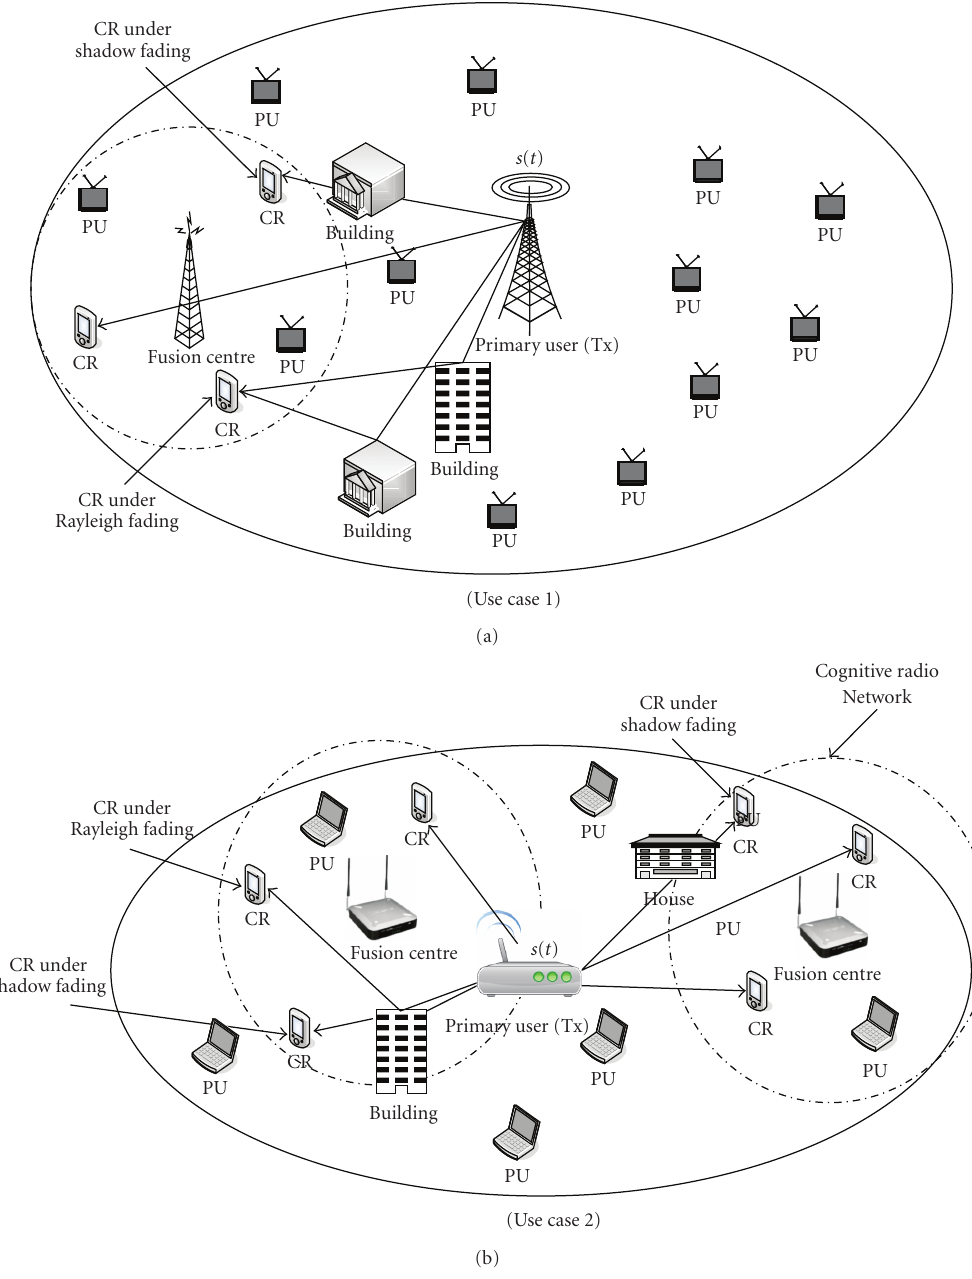
Figure 1: Use cases considered in